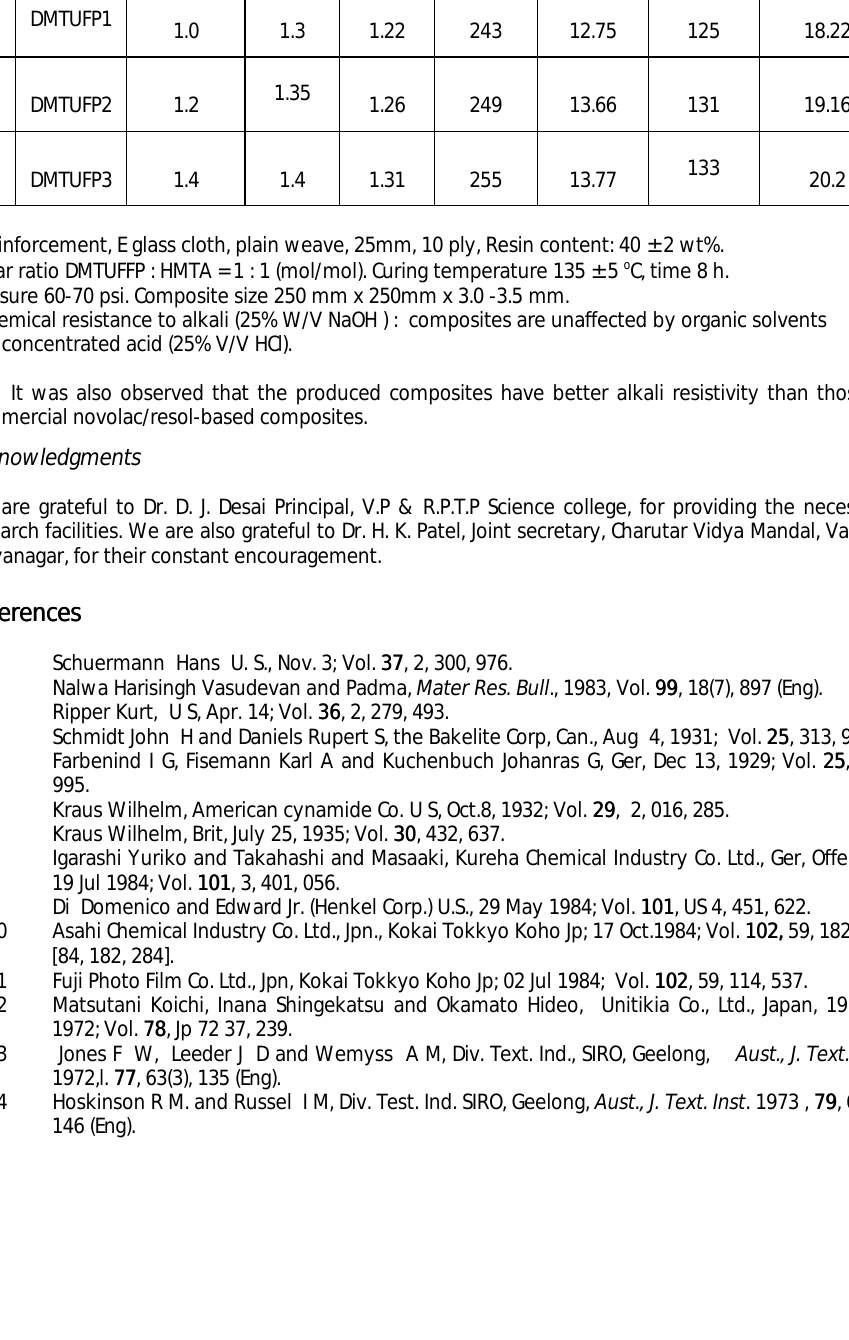
Table 5Table 5.. Mechanical and chemical properties of glass-reinforced DMTUFP-HMTA composites % change on exposure to 25% Sr. Sample (W/V) NaOH b No. Code Thickness Weight